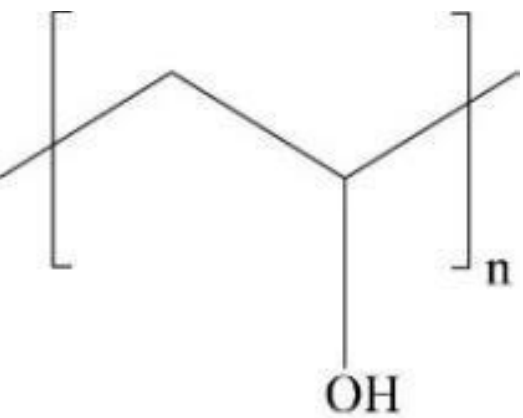
Figure 1. The structural formula of PVA.